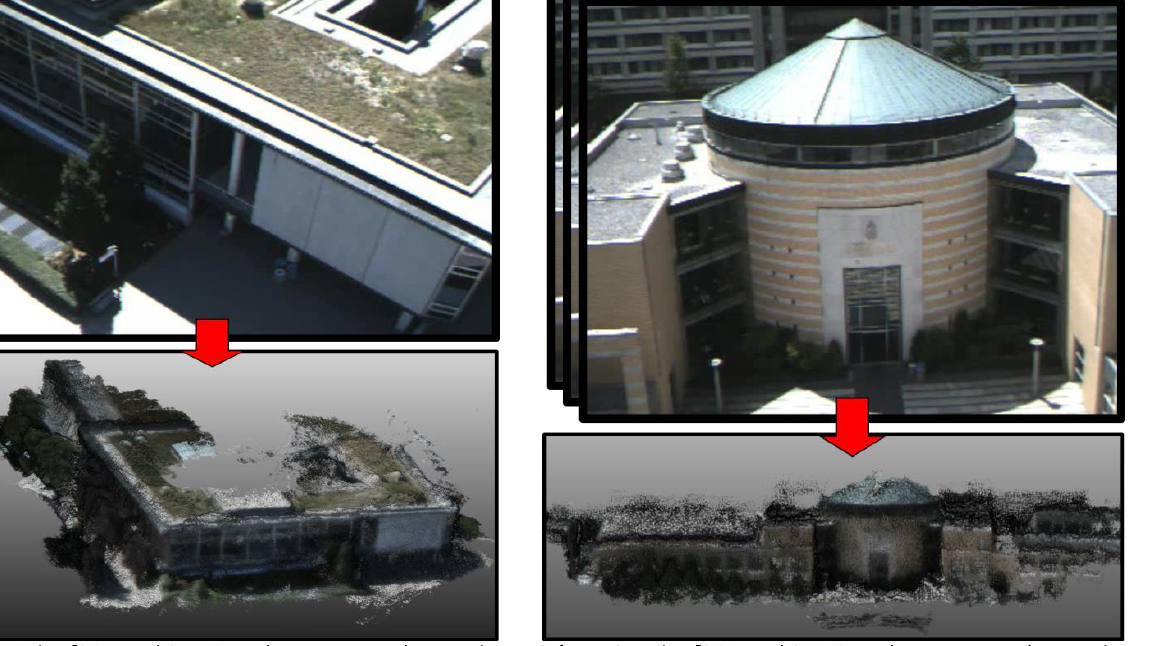
Figure 5: VisualSFM and SURE used to generate a dense point cloud of the Lassonde buiding from the sUAMS' video imagery.